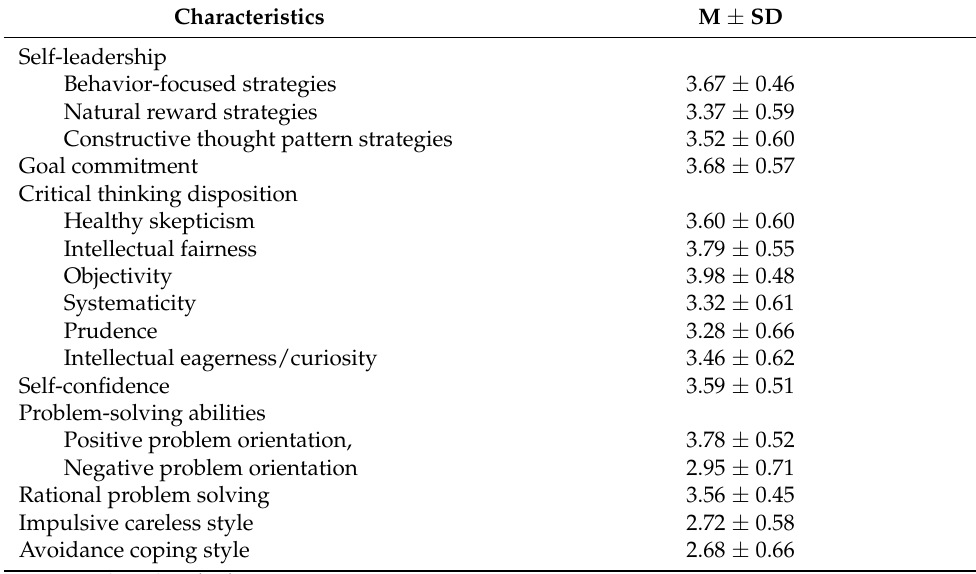
Table 1. Mean of Dependent and Independent Variables (N = 260).